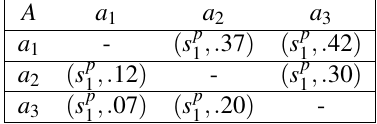
Table 12. Aggregated collective linguistic preference indexes in S p .